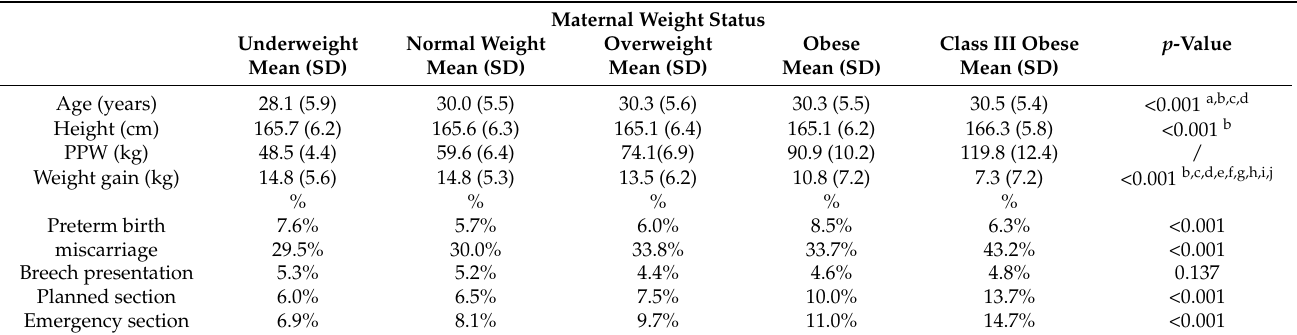
Table 2. Maternal parameters according to weight classes and obstetrical characteristics according to weight classes. Significance levels.